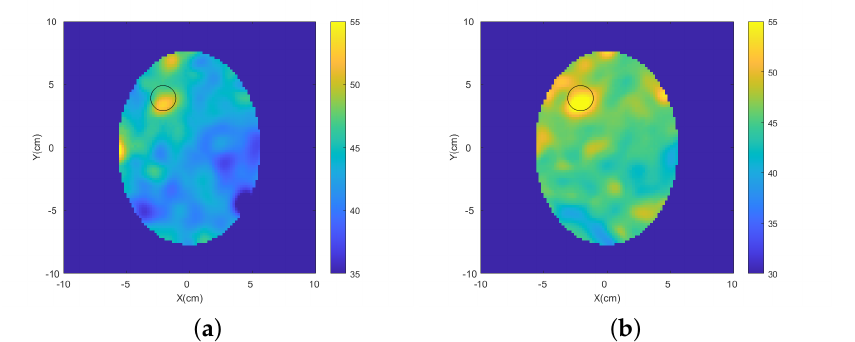
Figure 10. Frequency hopping reconstructions of the blood-mimicking target obtained from experi- mental data for the spear patch antenna array ( a ) without MTS and ( b ) with MTS.